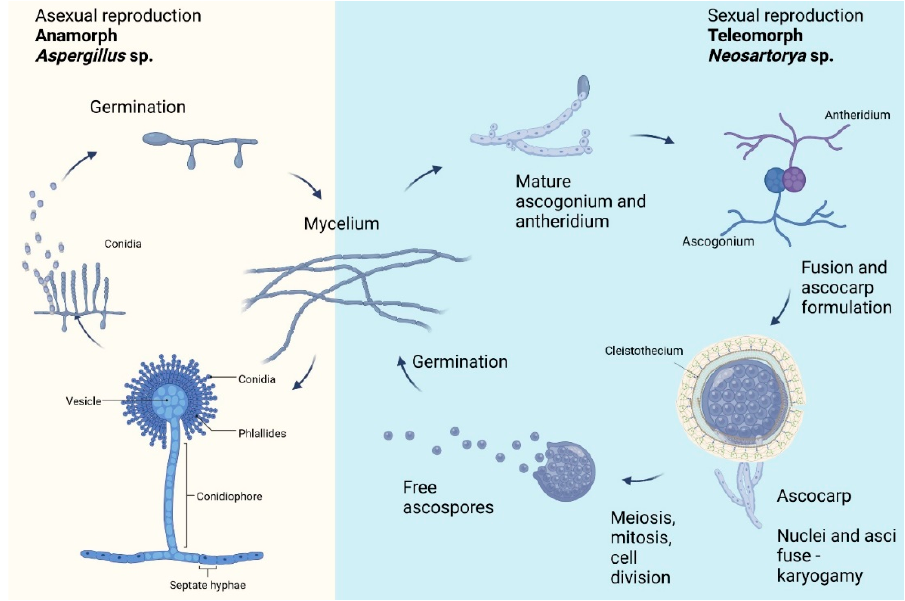
Figure 1. Life cycle of Neosartorya spp. with the stages of sexual and asexual reproduction (own elaboration by W. Maj and M. Fr ą c using BioRender, Toronto, ON, Canada).